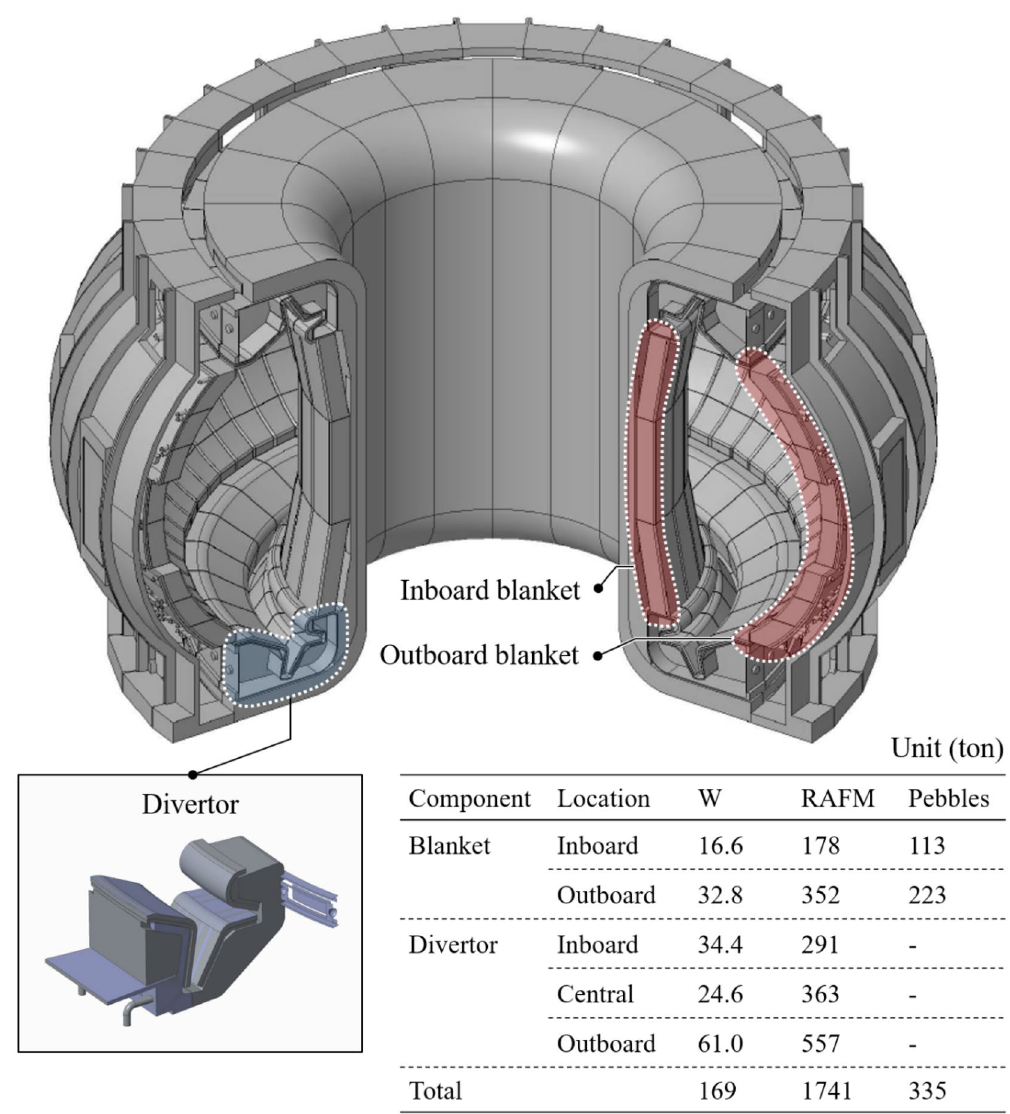
Figure 3. 270° cut-view of a conceptual drawing of K-DEMO with a detailed divertor component. The inset table presents the estimated weight of the in-vessel components during a periodic replacement. The functional materials of the breeder (Li 4 SiO 4 ) and neutron multiplier (Be 12 Ti) are in the form of pebbles. The structural material is reduced activation ferritic martensitic (RAFM)